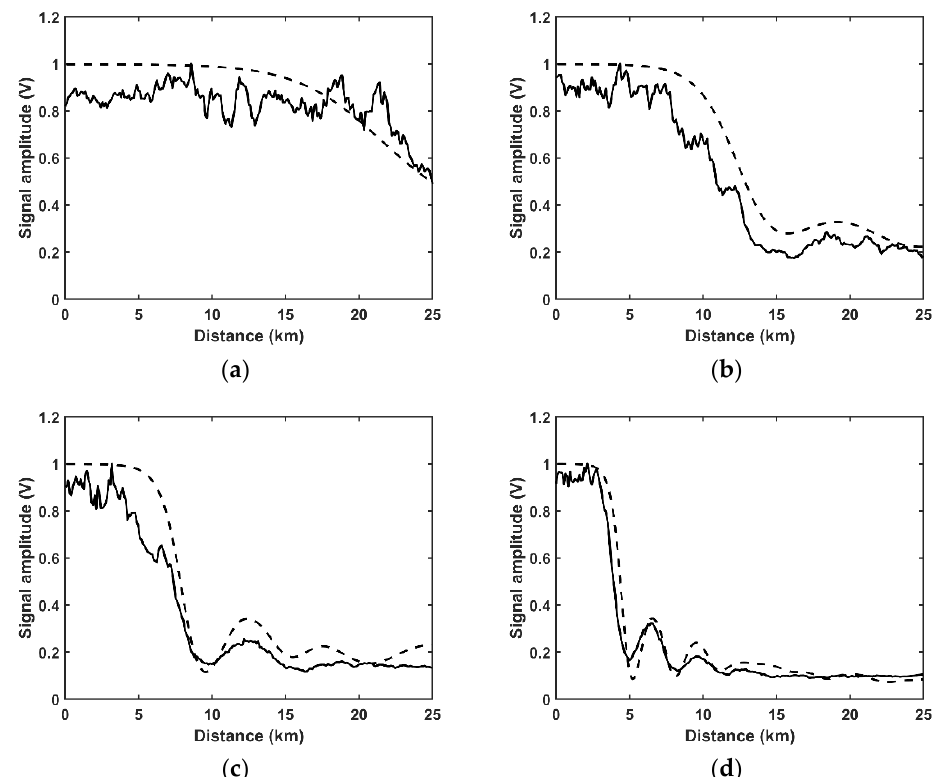
Figure 4. The evolution of normalized amplitude along the FUT in experiment (solid lines) and simulation (dashed lines): ( a ) 374 mW; ( b ) 500 mW; ( c ) 745 mW; ( d ) 1240 mW.